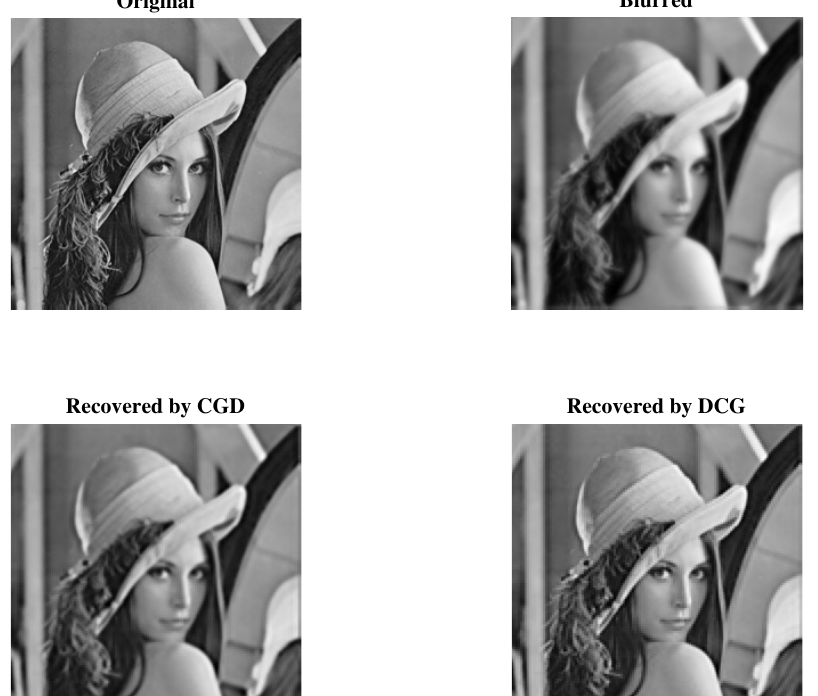
Figure 6. The original image ( top left ), the blurred image ( top right ), the restored image by CGD ( bottom left ) with SNR = 22.93, SSIM = 0.87 and by DCG ( bottom right ) with SNR = 24.36, SSIM =